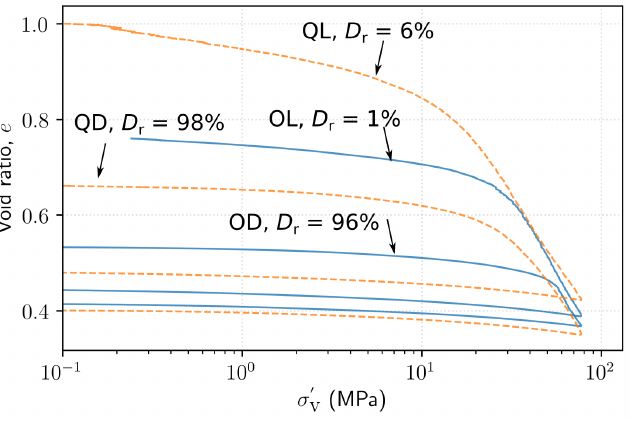
Figure 7. Results of displacement-controlled 1D compression tests on loose (L) and dense (D) specimens of Ottawa sand (O) and Q-Rok